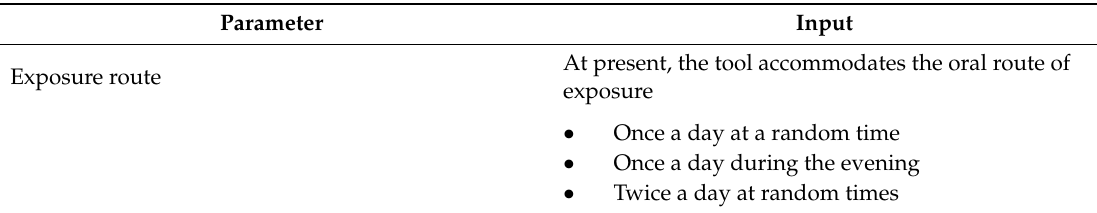
Table 1. Biomarker Reliability Assessment Tool (BRAT) parameters and